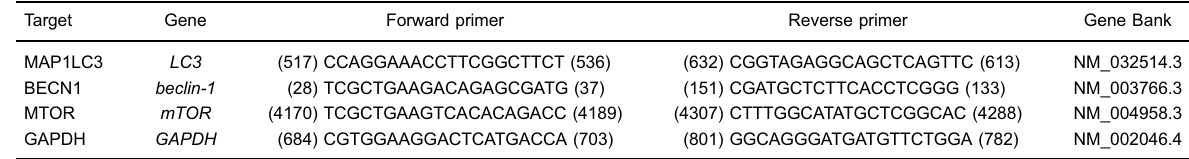
Table 1. Primers for autophagy genes and